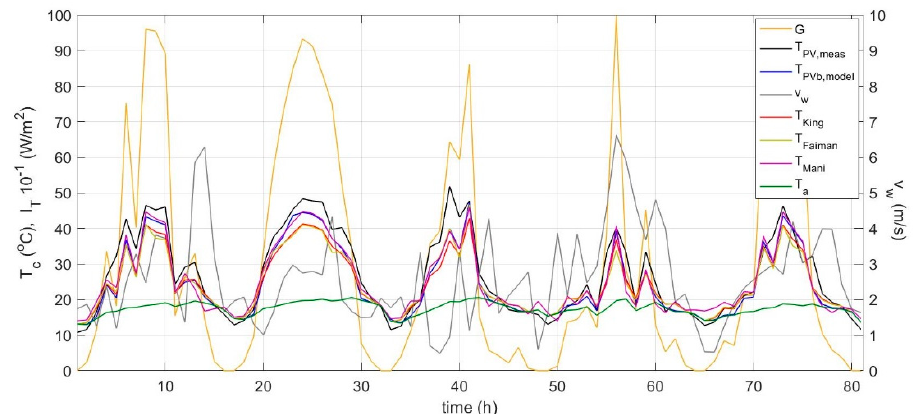
Figure 12. As in Figure 9, for the fixed-angle PV system during a period of 5 consecutive partly cloudy days in May and time interval of 1 h.